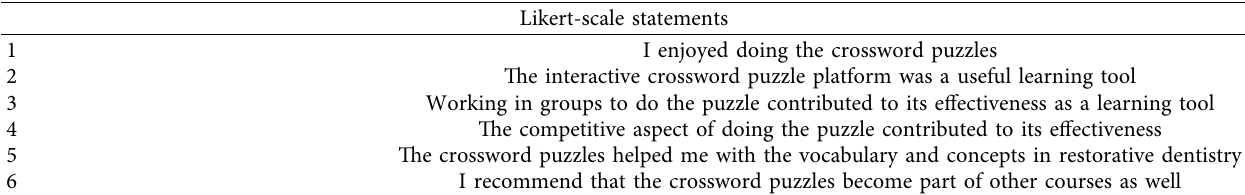
Figure 3: There was a hint for each question, which included snippets from lecture slides, scholarly articles, and textbooks. In the figure is a hint for Question 1 (across): “The adhesive system that first introduced the dual-cure Table 1: Likert-scale statements. Five responses were available for each statement: “strongly agree,” “agree,” “neutral,” “disagree,” and “strongly disagree.”